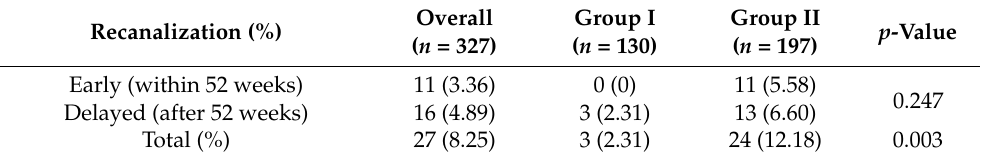
Overall Group I ( n = 327)